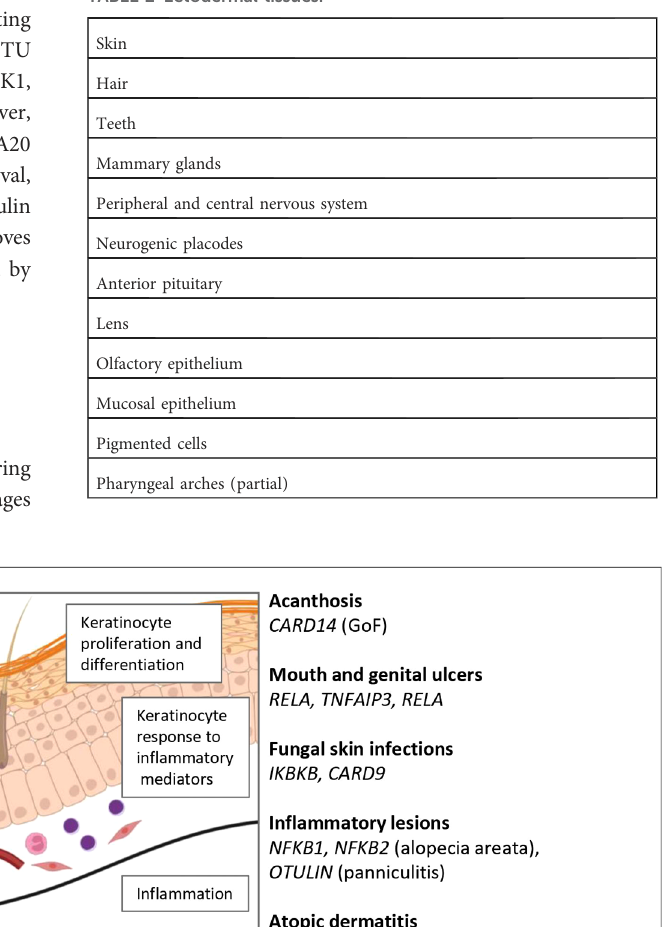
TABLE 2 Ectodermal tissues.